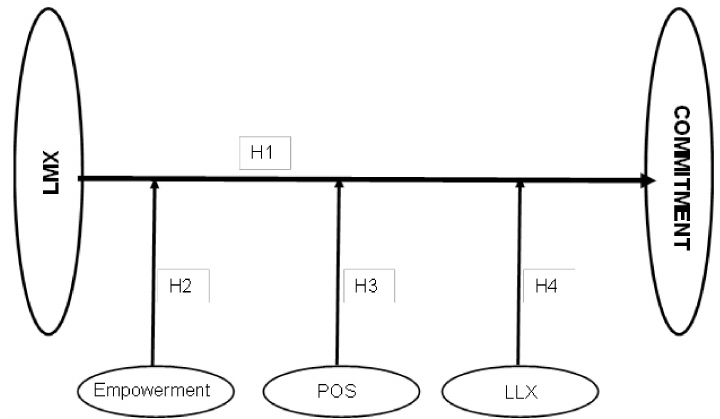
Figure 1. The research